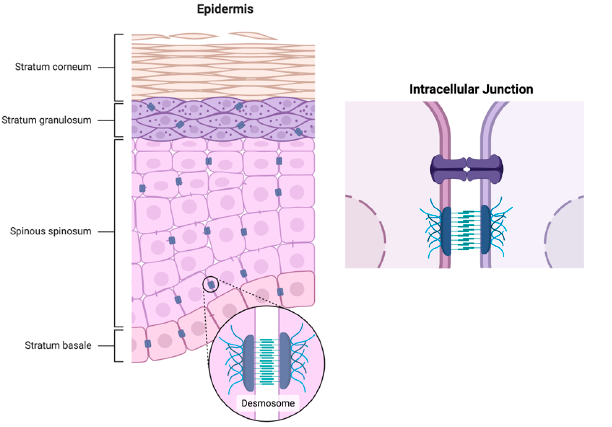
Figure 1. Desmosomes favor cell aggregation and connections (Reprinted from “desmosomal protein distribution in the epidermis”, by BioRender